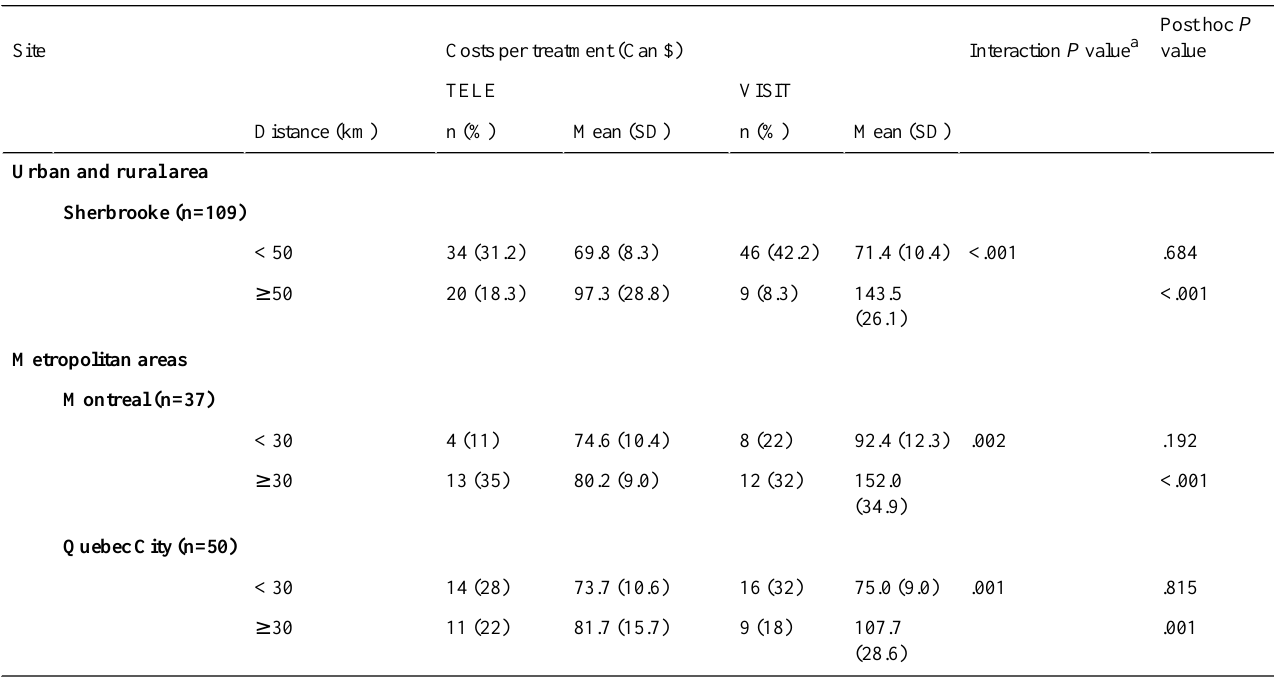
Table 6. Cost sensitivity analysis based on round-trip distance from health care center to patient’s home, calculated separately for each